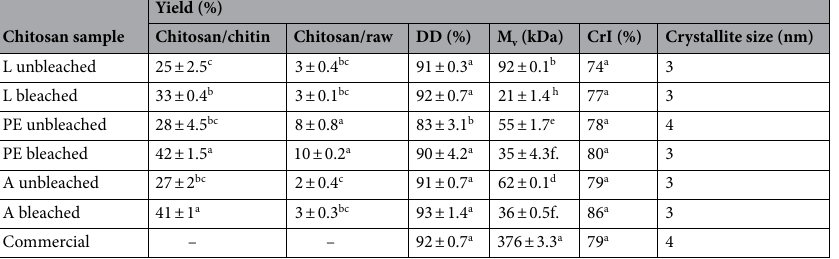
Table 4. Yields (%) related to chitosan, deacetylation degree (DD), viscosity-average molecular weight (M v ), crystallinity index (CrI %) and crystallite size (nm-D 100 ) of chitosan obtained from both bleached and unbleached chitin from H. illucens larvae (L), pupal exuviae (PE) and dead adults (A) and a commercial chitosan derived from shrimp shells. Data are expressed as mean ± standard deviation. Different letters in a column indicate significant differences ( p < 0.05) in the yields, DD, M v or CrI among the samples (data analyzed with Chi-square test with Yates’